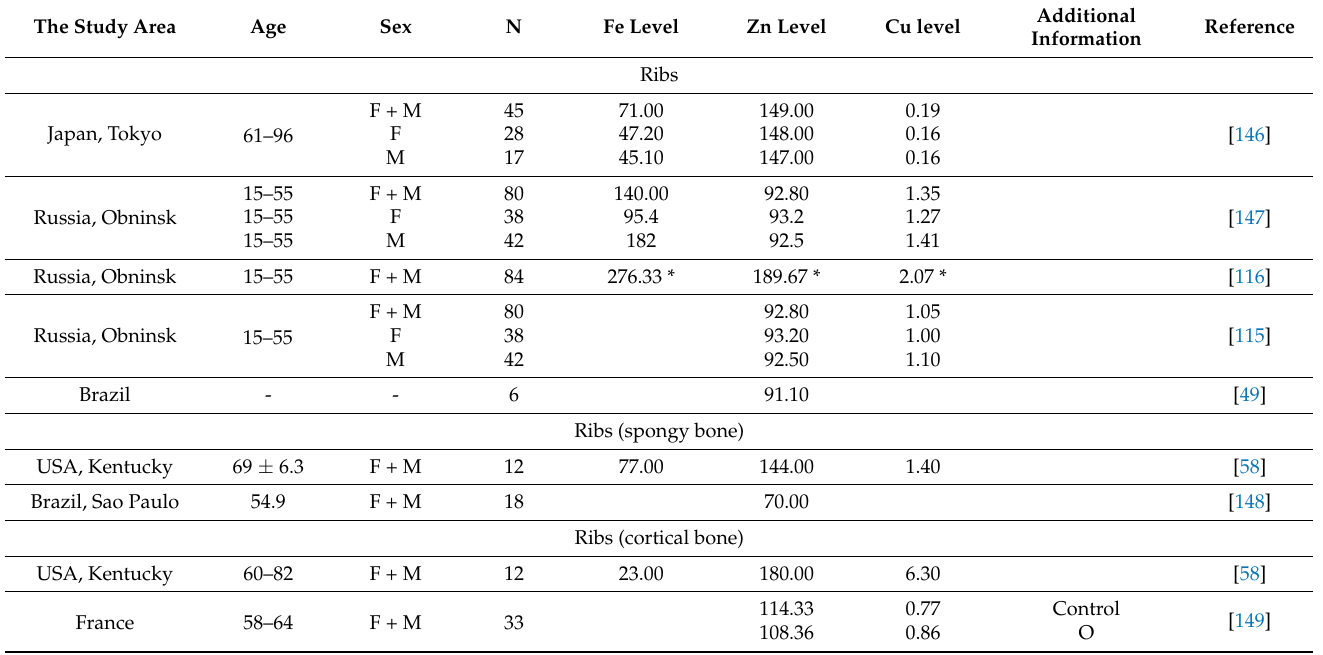
Table 1. Iron, zinc, and copper levels in human bones in mg/kg dw (F, female; M, male; n, number of participants; A; alcohol consumers; NA, non-alcohol consumers; NS, non-smokers; S, smokers; O, osteoporosis; NO, no osteoporosis; * data converted from wet weight to dry weight assuming that the average water content of the bones is 30% of their